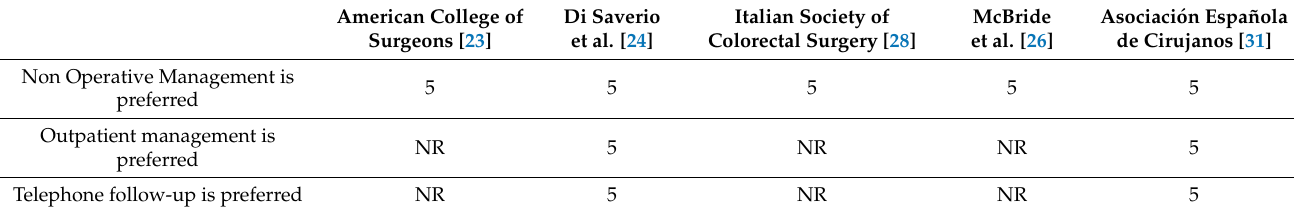
Table 5. Preferred strategy for uncomplicated acute diverticulitis during COVID-19 pandemic. American College of Surgeons